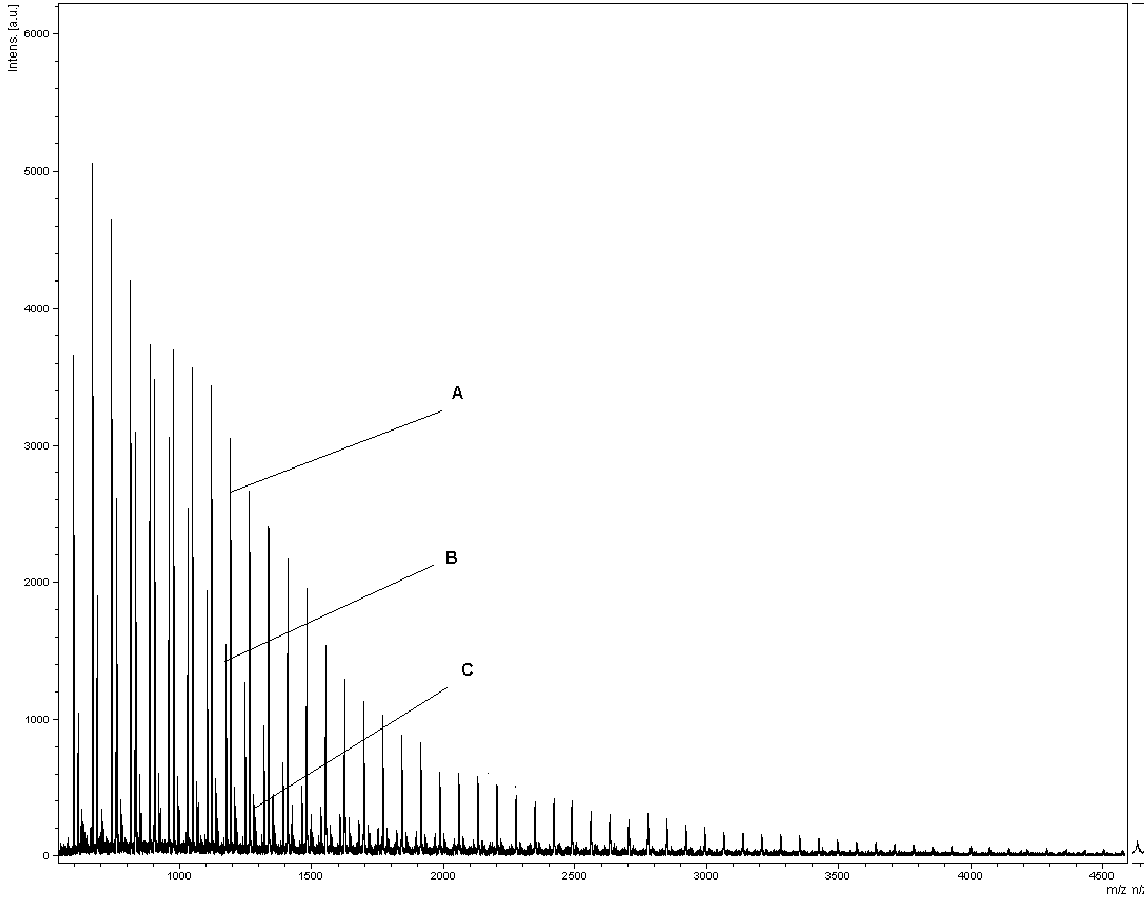
Figure 2 . MALDI-TOF spectrum of PLA synthesized in the presence of Pet and SnOct